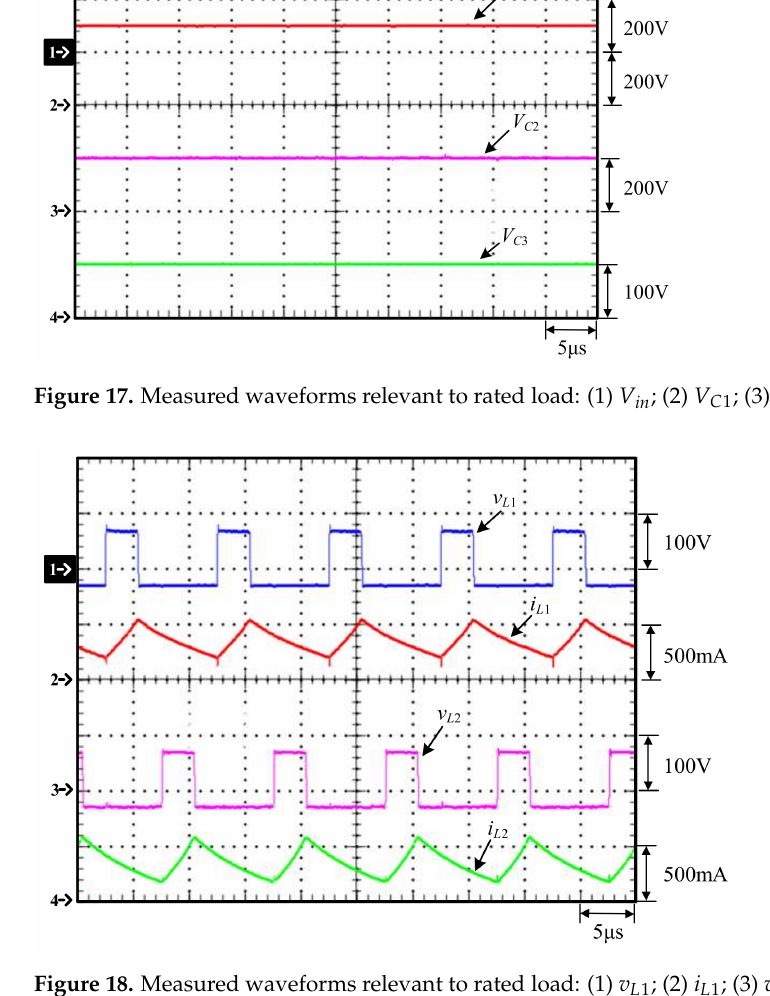
Figure 18. Measured waveforms relevant to rated load: (1) v L 1 ; (2) i L 1 ; (3) v L 2 ; (4) i L 2